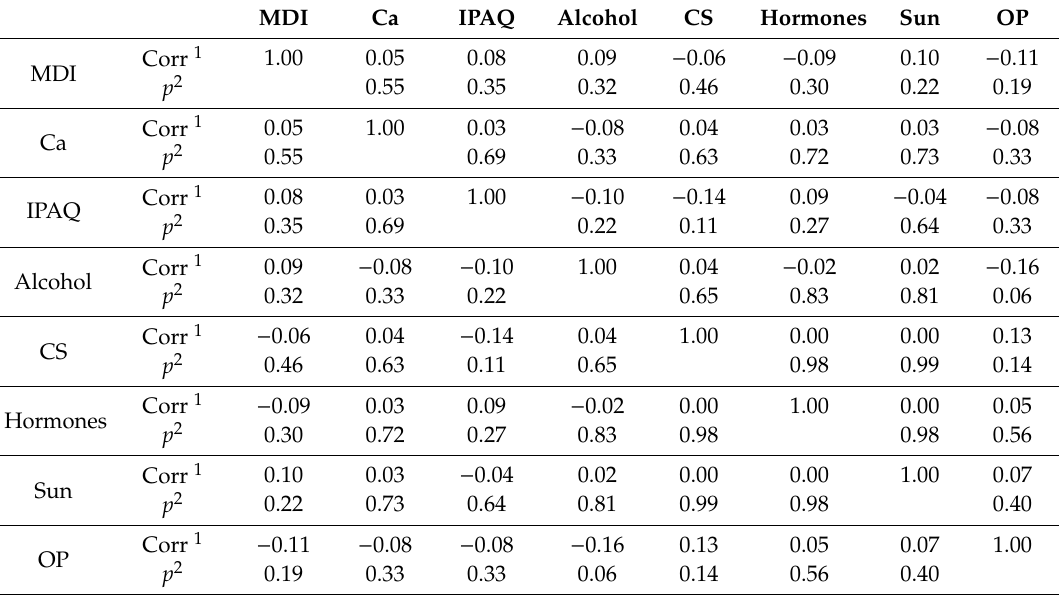
Table 3. Correlations of variables of interest, adjusted by age and body mass index.